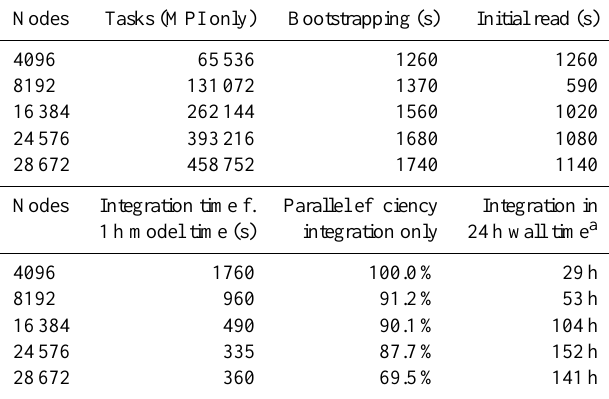
Table 3. MPAS-A 3km global simulation experiment (strong scal- ing tests). Nodes Tasks (MPI only)